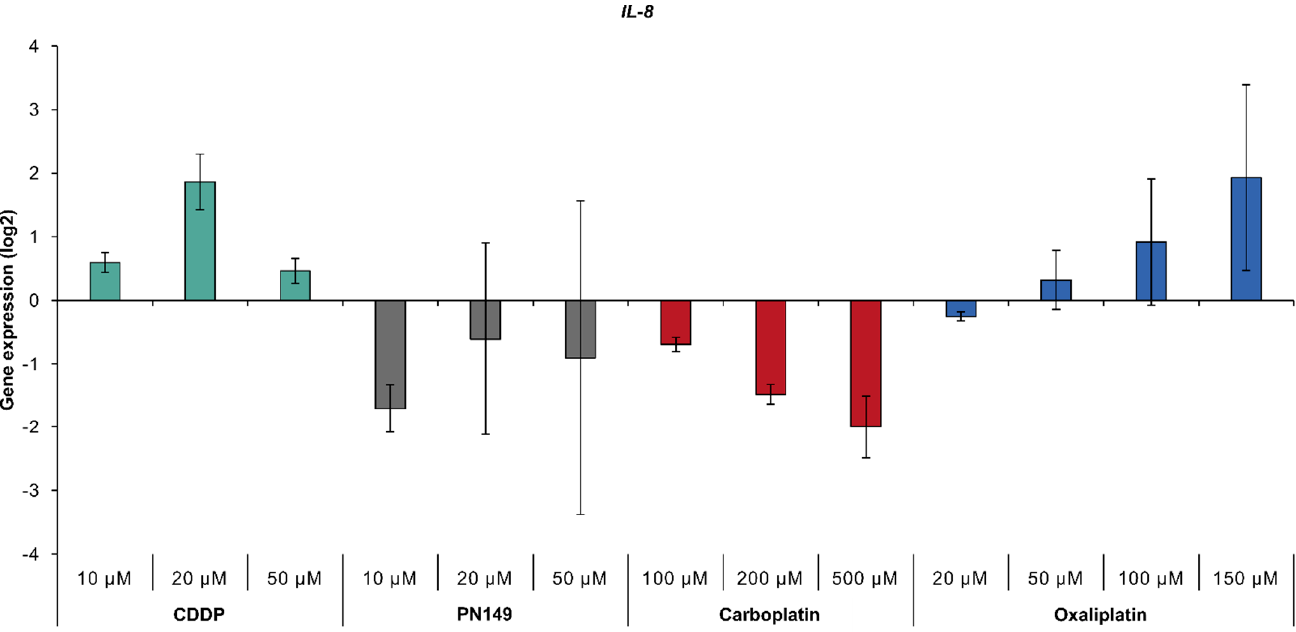
Figure 5. Gene expression of IL-8 gene. ciPTECs were treated with PN149 or cisplatin (10, 20, 50 µM), carboplatin (100, 200, 500 µM) or oxaliplatin (20, 50, 100 and 150 µM) for 24 h. Gene expression was determined by high-throughput RT-qPCR. Shown are the log2 mean values of three independent experiments normalized to the untreated control, whereby the control equals 0.